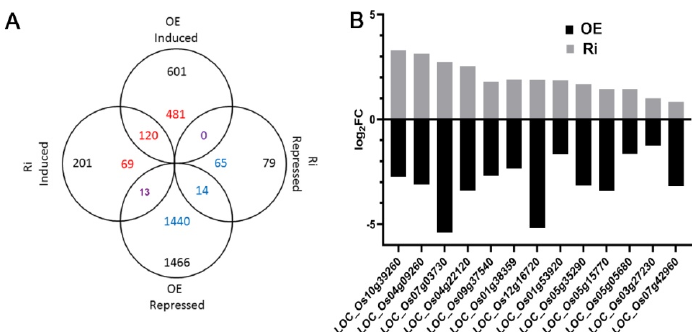
Figure 4. Differentially enriched genes in the lesion mimic and leaf senescence pathways. OE indi- cates the overexpression line, Ri indicates the RNA interference line, abscissa indicates a log2 fold change, and ordinate indicates the locus name of the gene.